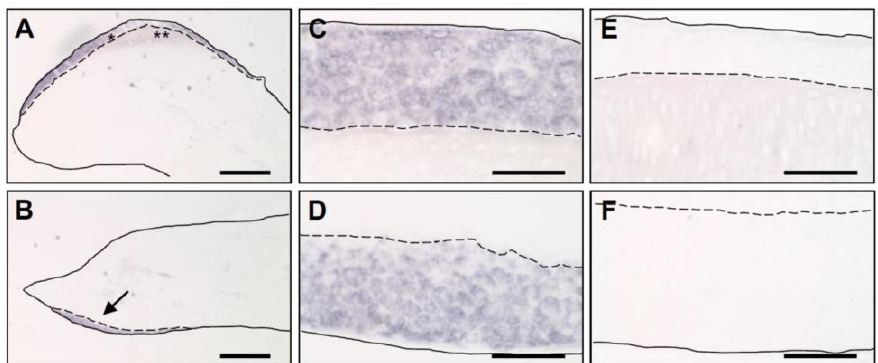
Figure 4. CRNN mRNA is expressed in the peridermal compartment of the chicken egg tooth. To localize CRNN mRNA-expressing tissues, an in situ hybridization of sections through the beak of chicken embryos at developmental stage E10 was performed. Pictures of the upper beak ( A , higher magnification C ) and lower beak ( B , higher magnification D ) are shown. The signal detected in the lower beak is indicated by an arrow ( B ). As negative control, the sense probe was applied to the upper ( E ) and lower beak ( F ). *, peridermal compartment of the egg tooth; **, cornified egg tooth. Bars: 400 µm ( A , B ), 40 µm ( C – F ).